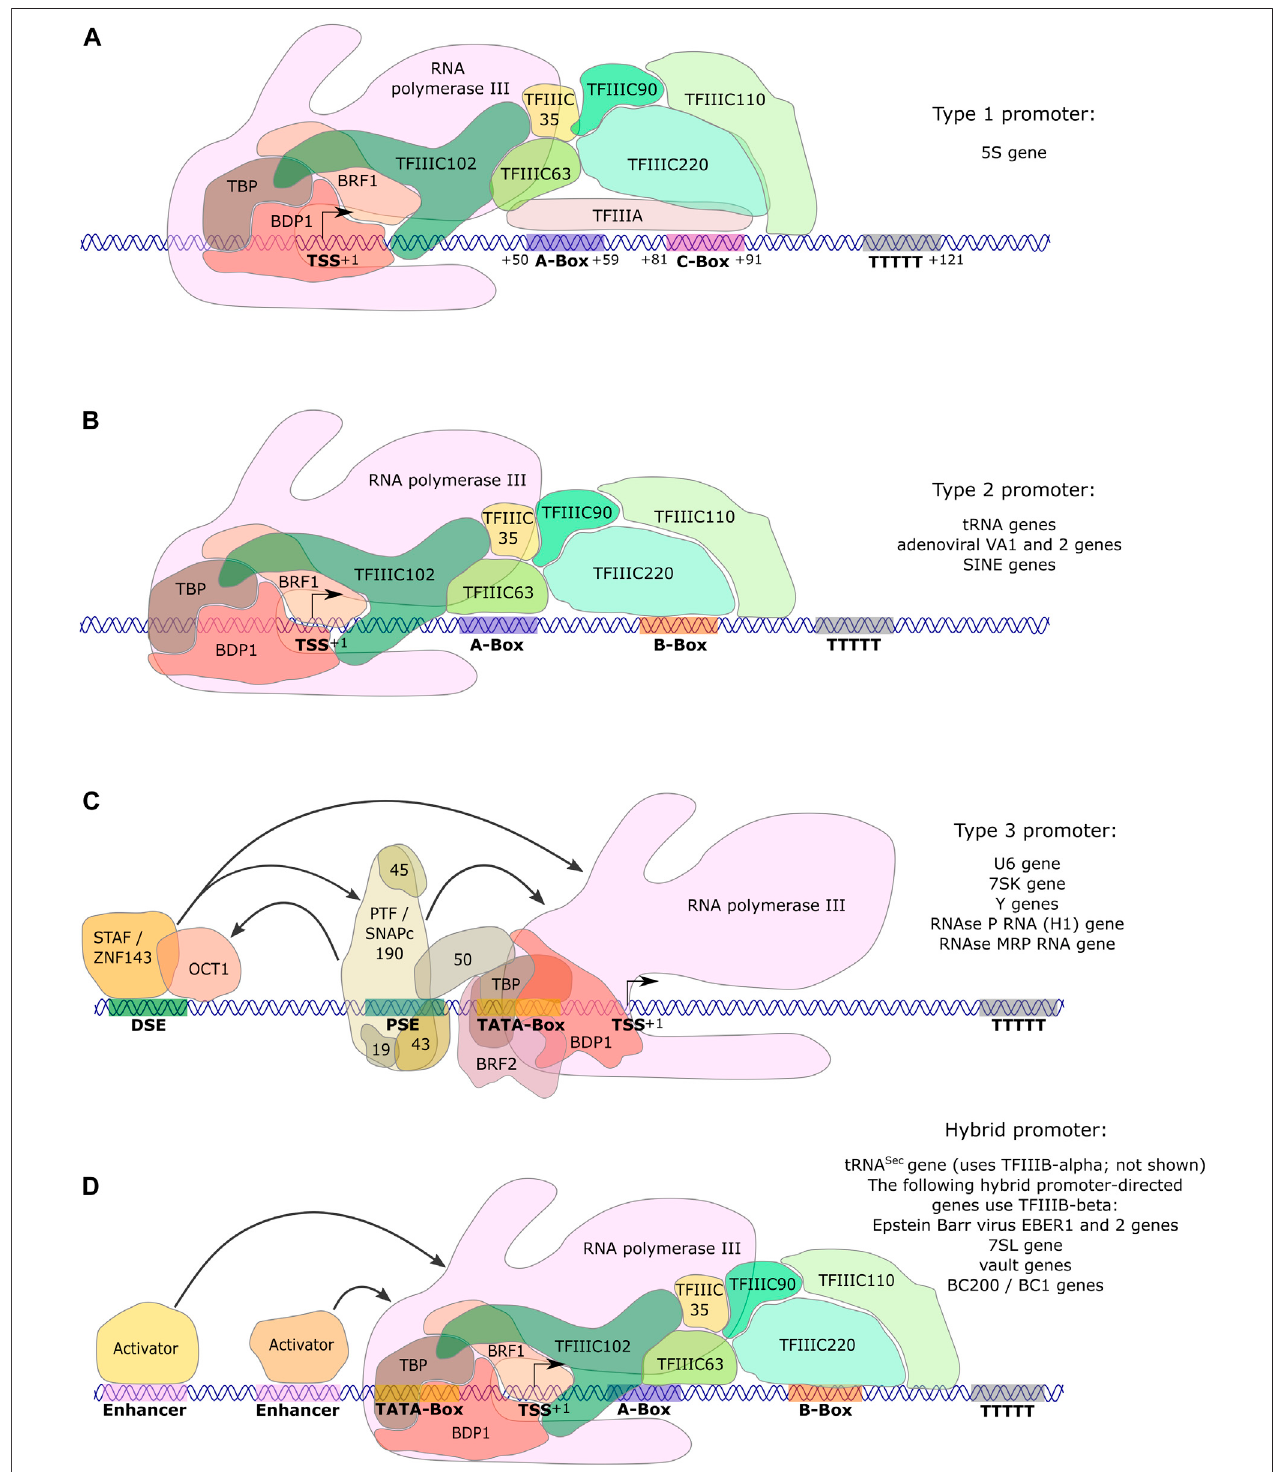
FIGURE2| Promoters directinghumanRNApolymerase IIItranscription.PolIIItype1andtype 2genescontaingene-internal promoterelements. (A) Type1gene transcriptionof5Sribosomal(r)RNAisdirectedbyA-andC-boxesthatarelocatedrelativetothetranscriptionstartsite(TSS)asindicated.Thesepromoterelementsare bound byTFIIIA,permittingtherecruitmentofTFIIICandsubsequentlyofTFIIIB- β (composedofTBP,BDP1and BRF1),whichaltogetherrecruit PolIII. (B) Type 2genes (tRNA genes, VA1, VA2, SINEs) contain A- and B-boxes as promoter elements at varying positions relative to the TSS. They are bound by TFIIIC, subsequently